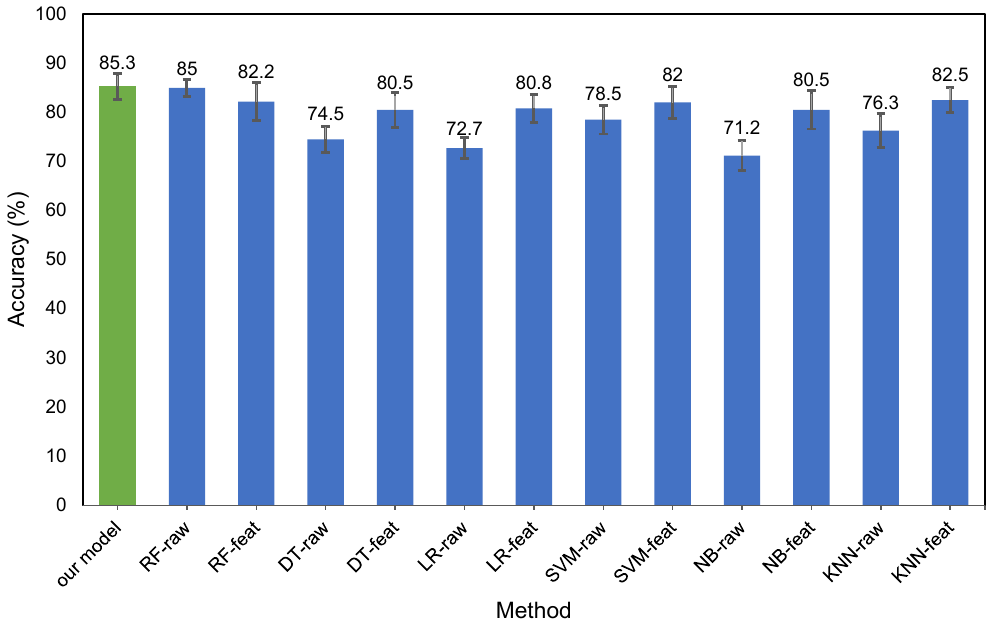
Figure 6. The accuracy of the other methods in comparison to our FCNN model. The abbreviations are as follows—RF: Random Forest, DT: Decision Tree, LR: Logistic Regression, SVM: Support Vector Machine, NB: Naive Bayes, KNN: K -Nearest Neighbors. The suffix “raw” refers to inputs in the raw data format and “feat” refers to inputs as features extracted from the FCNN model.